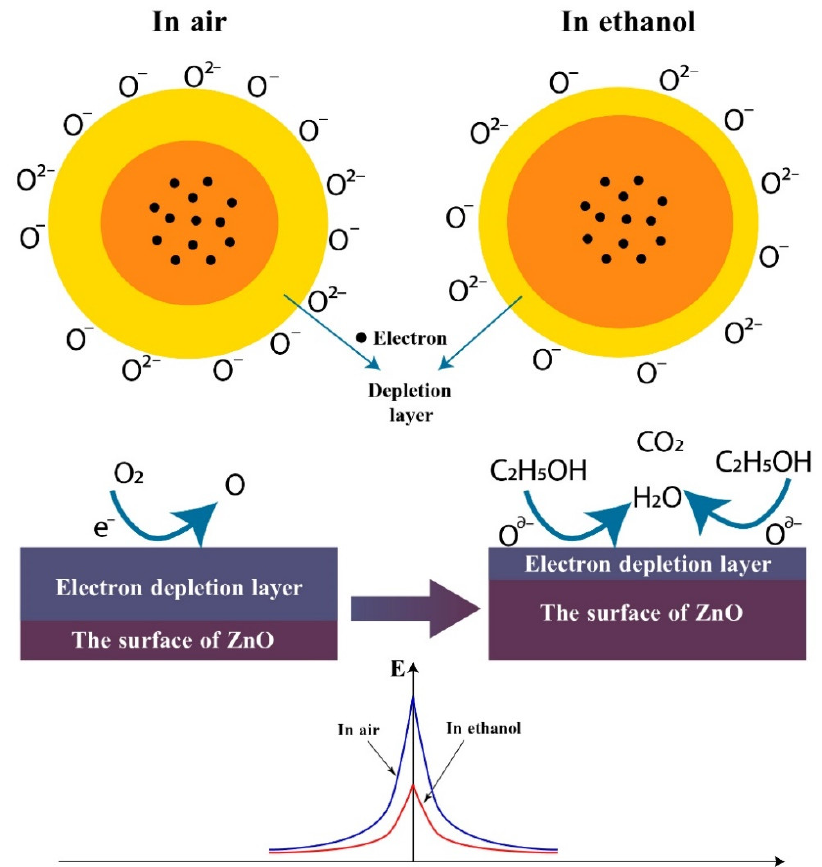
Figure 12. Schematic diagram of the proposed reaction mechanism of the ZnO to ethanol.